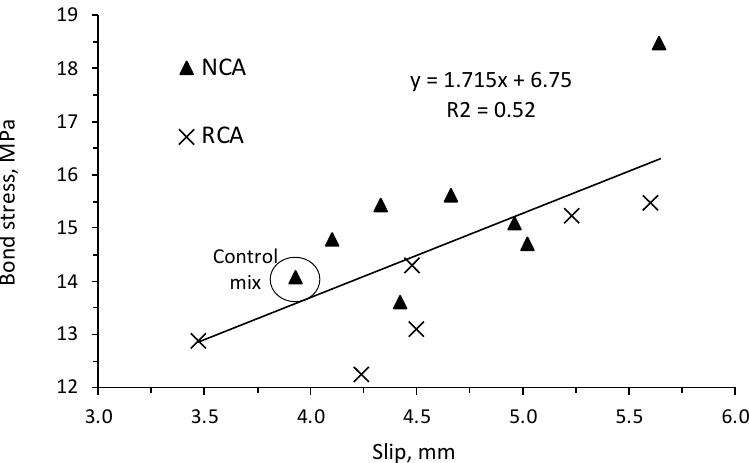
Figure 8. Relationship between the bond strength and slip at failure for all tested mixtures.